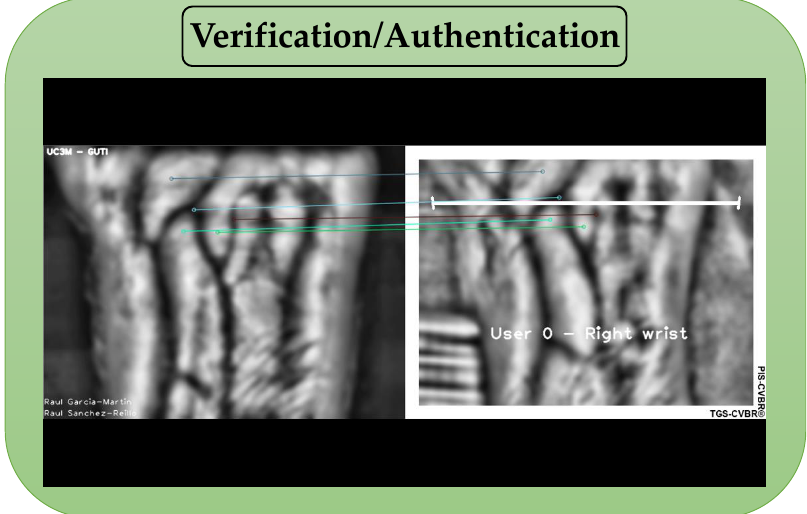
Figure 7. TGS-CVBR ® and PIS-CVBR ® union: User 0 real-time authentication (screenshot). Unique user image pattern ( left side) comparison with video ( right side) using (SIFT algorithm, 7 – 8 FPS). In the video, the word “User” refers to the subject , and the wrist is predefined (User 0 = Subject 0 and Right wrist, User 1 = Subject 0 and Left wrist).